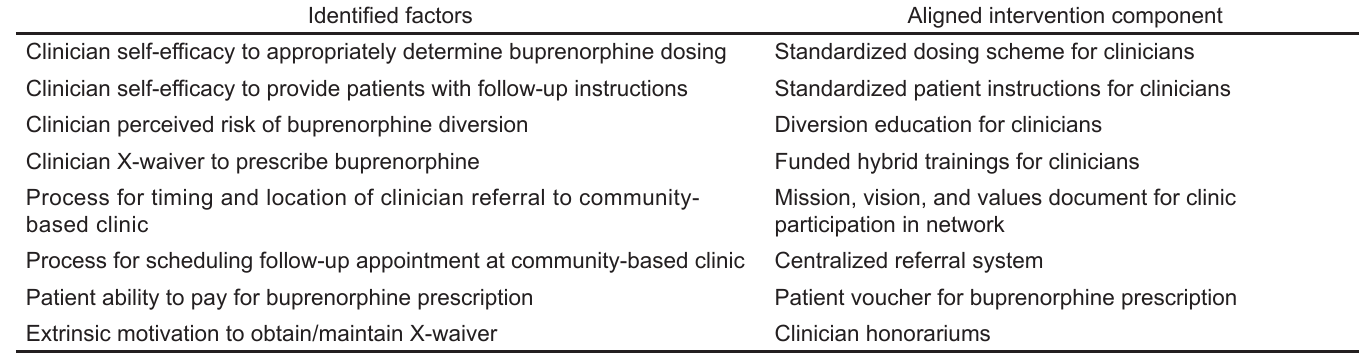
Table 2. Intervention alignment to identified